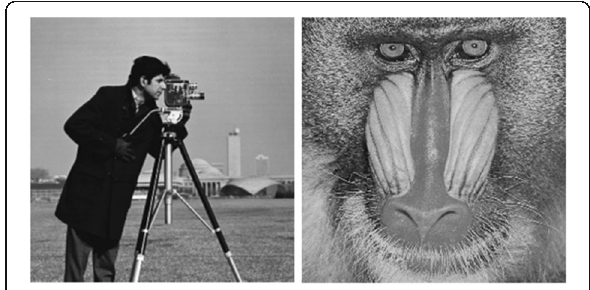
Fig. 8 Original images, images from left are Cameraman and